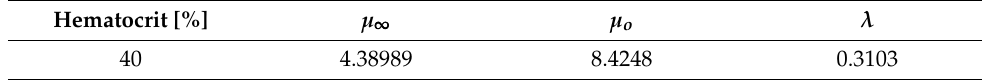
Table 4. Tabulated value for Carreau-Yasuda model constants. Hematocrit